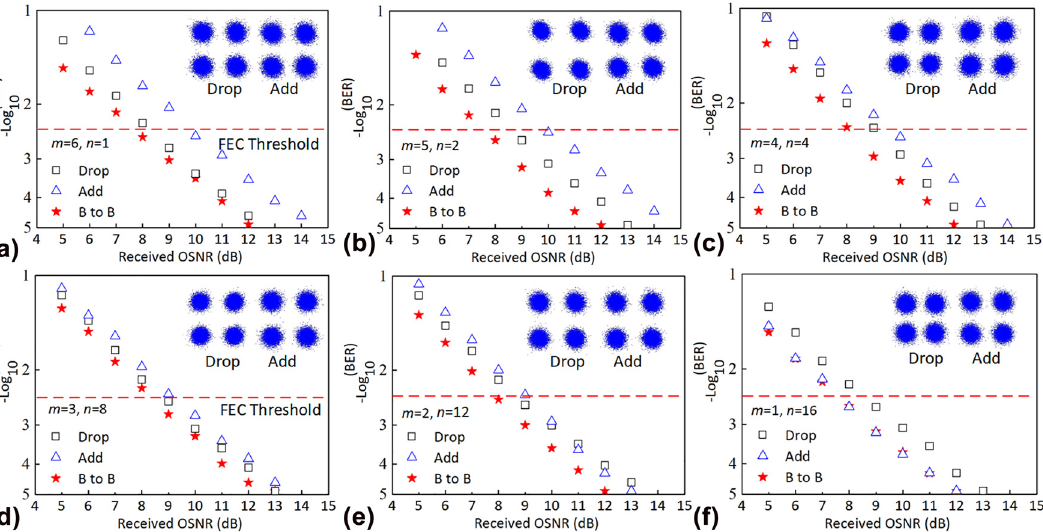
), (a) m = 6, n = 1; (b) m = 5, n = 2; (c) m = 4, m:n